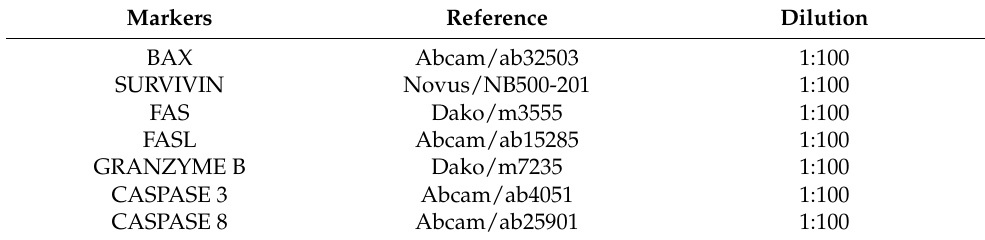
Table 1. Antibodies used to monitor apoptosis in fatal human YF cases.